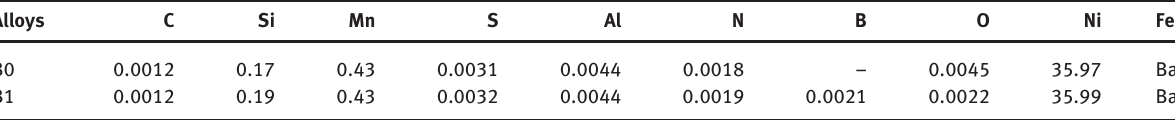
Table 1: The chemical compositions of the investigated alloys (mass fraction/%). Alloys